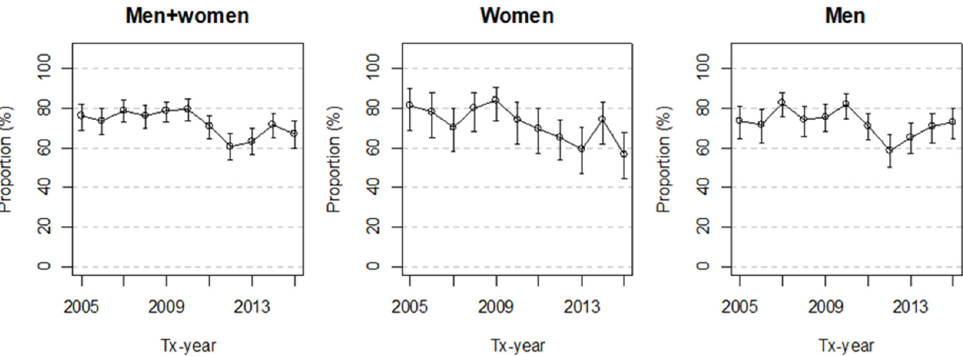
Figure 2. Proportion (%) of kidney transplant recipients according to year of transplantation (2005–2015) with statins dispensed in the first year after transplantation in total, and according to sex (with 95% confidence intervals). Tx—transplantation.